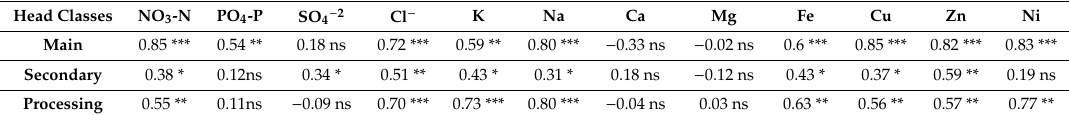
Table 7. Pearson’s correlation coe ffi cient values between mineral profile of heads content by artichoke classes and irrigation water